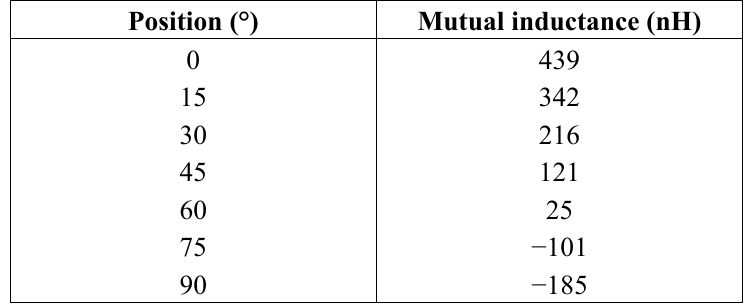
Table 1. Calculated mutual inductance for different positions of the rotor coil related to the stator coil.